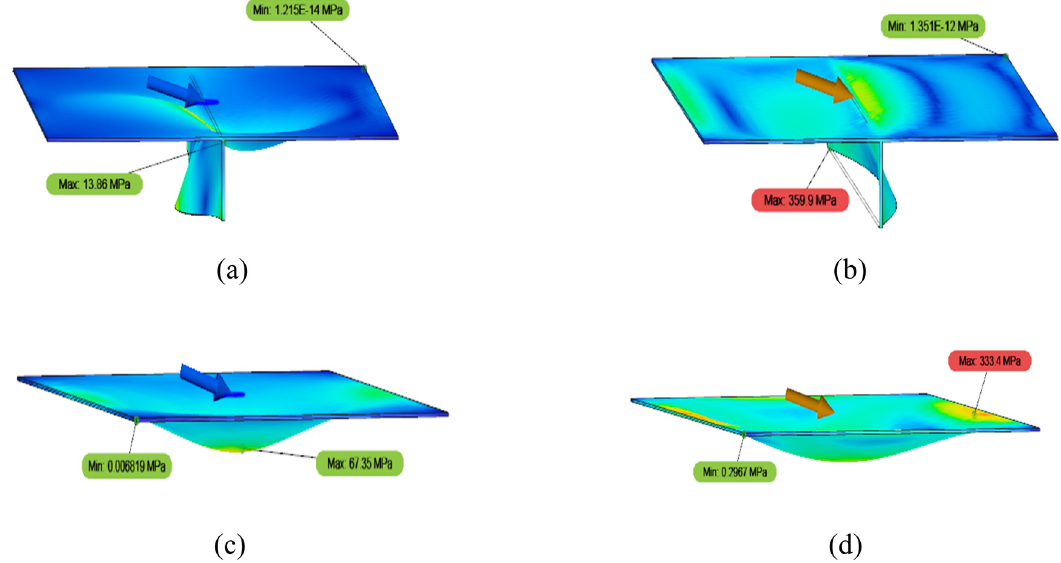
Figure 14: The von Mises stress contour at a load angle of 75° between sti ff ened and unsti ff ened low - carbon steel plates with a centred load ( Models 1 and 3 ) and global linear load ( Models 2 and 4 ) : ( a ) Model 1, ( b ) Model 2, ( c ) Model 3, and ( d ) Model 4.